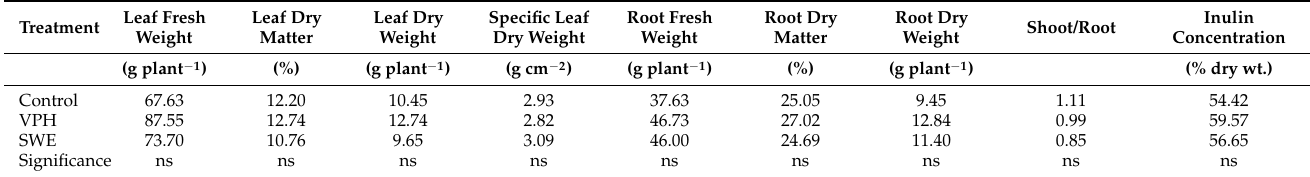
Table 5. Effects of plant biostimulants on fresh and dry biomass of leaves and roots, root characteris- tics, shoot to root ratio, and root inulin concentration in growth chamber chicory trial.